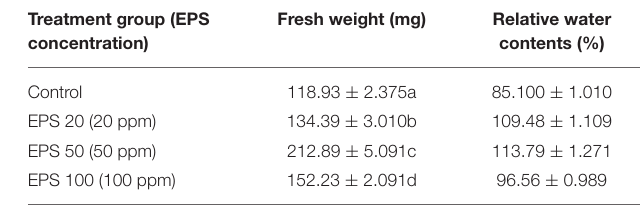
TABLE 6 | Monosaccharide compositions of C . alatae LCS1 heteropolysaccharide. Sl. No.